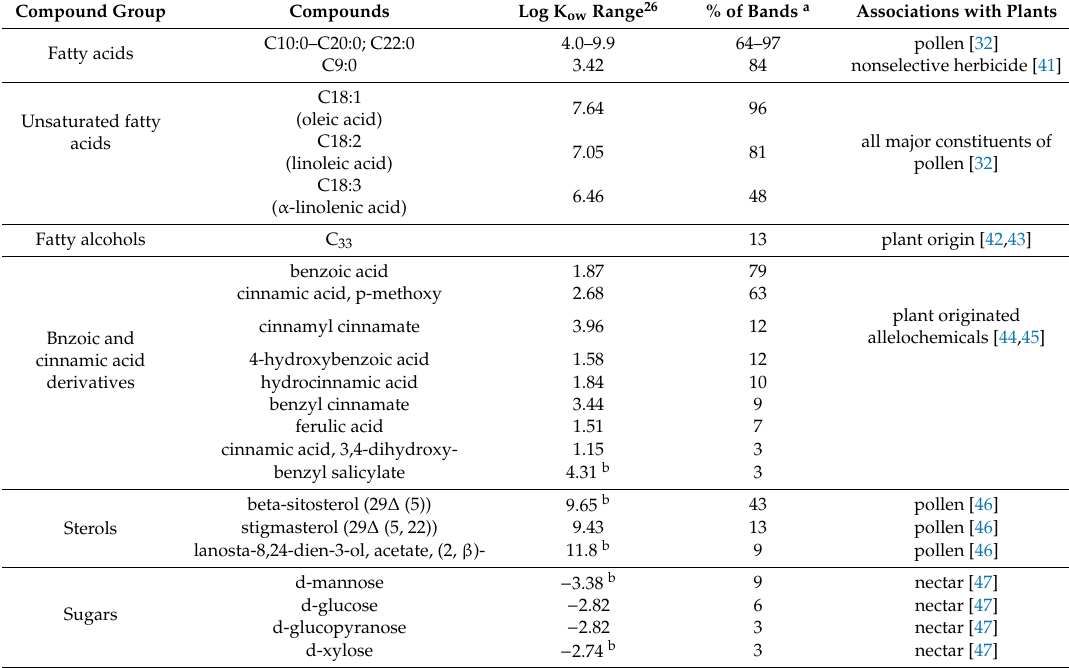
Table 2. The percentage of silicone bands placed in honey bee hives that contain plant-associated compounds organized by compound